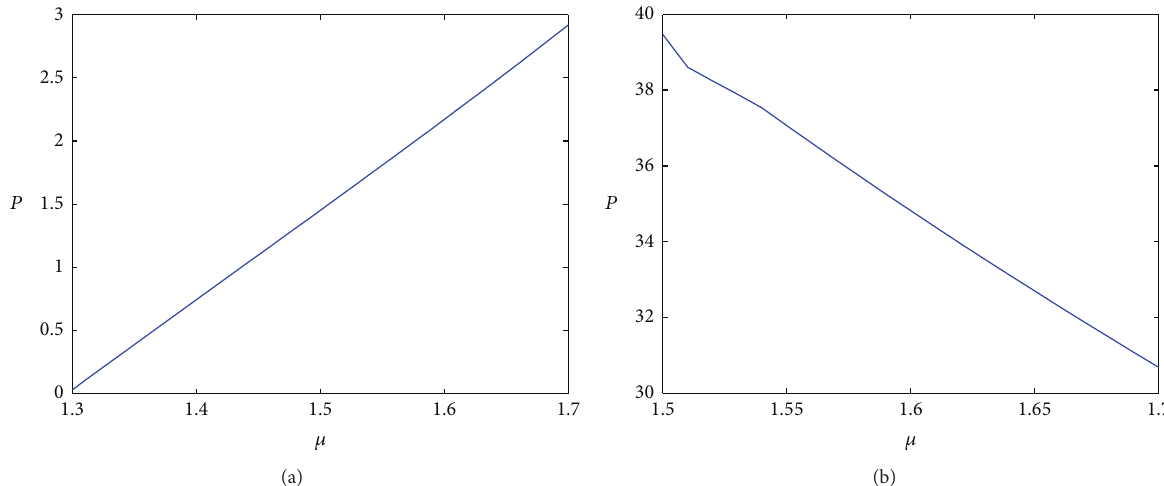
Figure 6: The power of the lattice solitons for the self-focusing cubic and the self-focusing quintic model versus the propagation constant for the Penrose potential. (a) The power of the solitons obtained by the use of the first renormalization factor versus 𝜇 . (b) The power of the solitons obtained by the use of the second renormalization factor versus 𝜇 .